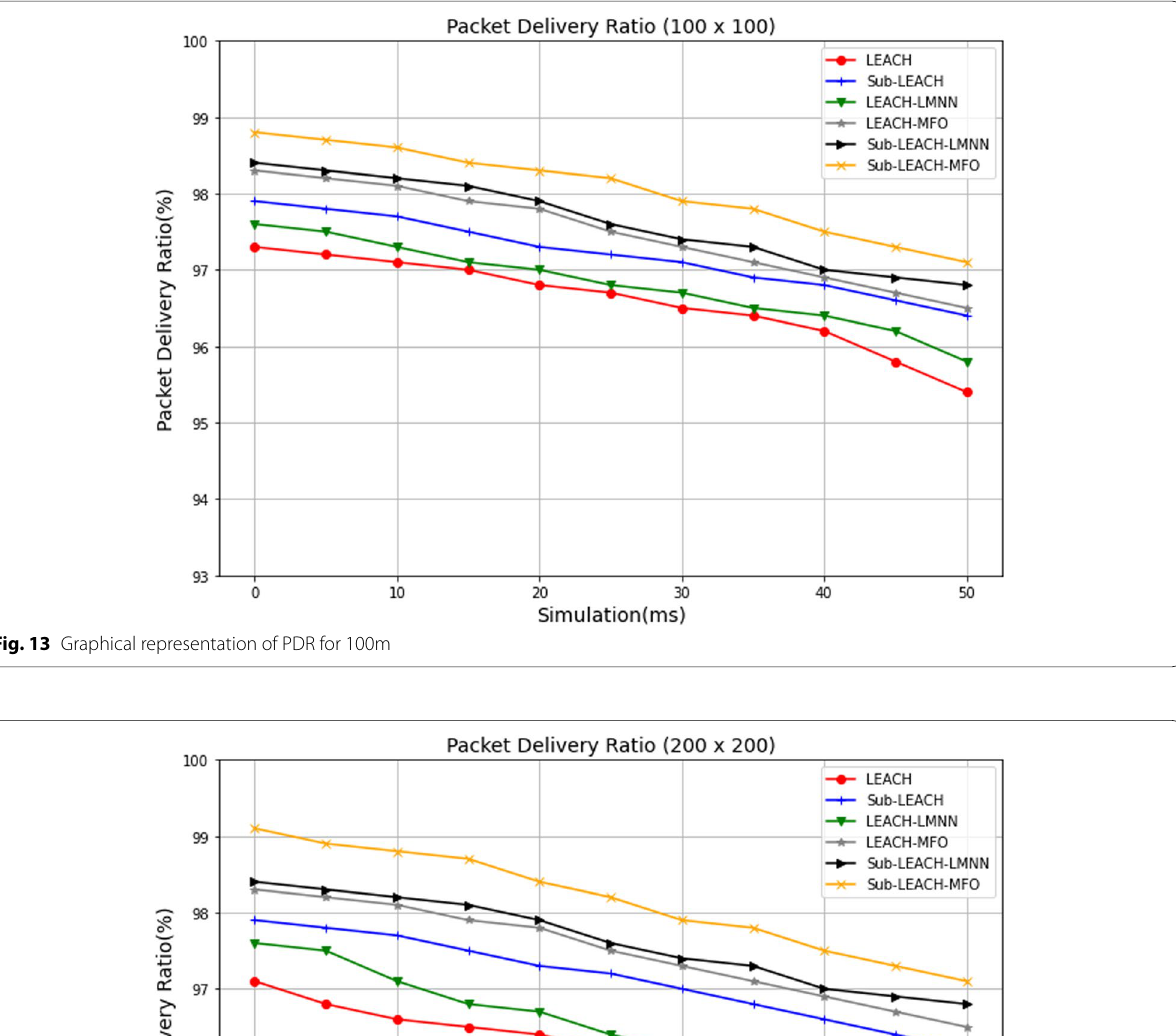
Fig. 14 Graphical representation of Packet PDR for